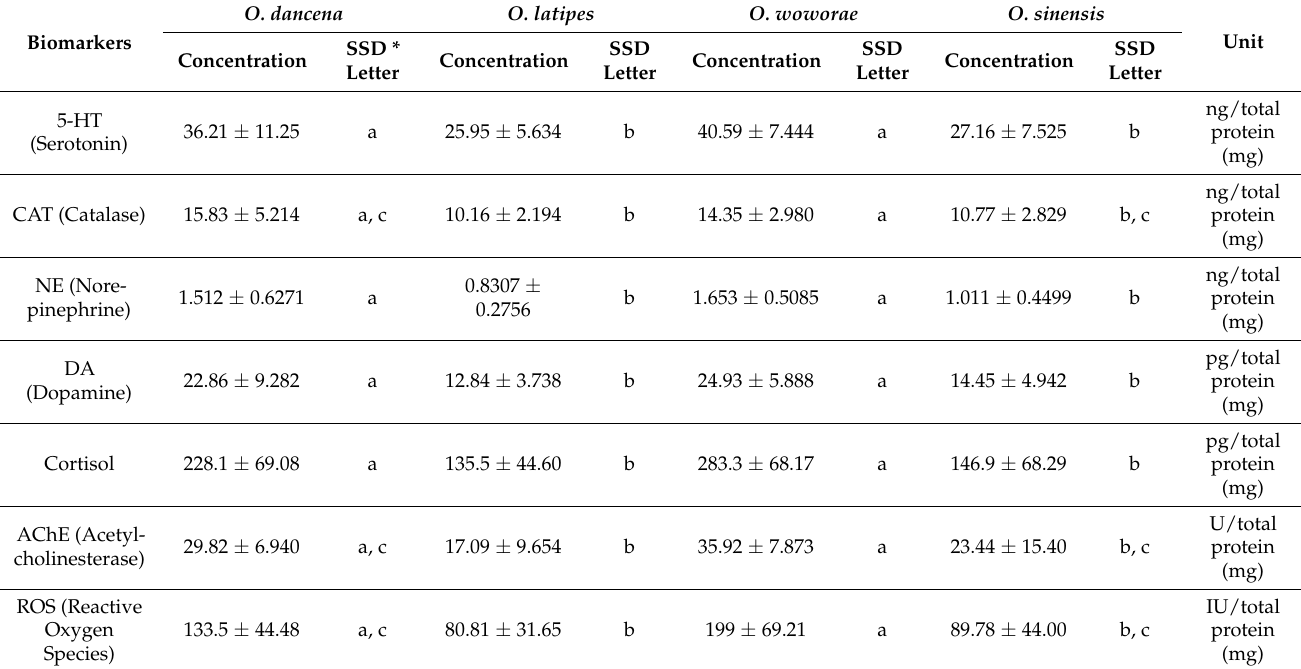
Table 1. Comparison of neurotransmitters, antioxidant activity, and oxidative stress contents in each medaka species brain tissue measured using enzyme-linked immunosorbent assay (ELISA). The data are expressed as the mean with SD. Kruskal–Wallis test continued with uncorrected Dunn’s test was used to analyze the data. Different SSD letters (a, b, c) represent significant statistical differences ( p < 0.05; n = 10 for all groups; * SSD = statistically significant difference). O. dancena O. Biomarkers